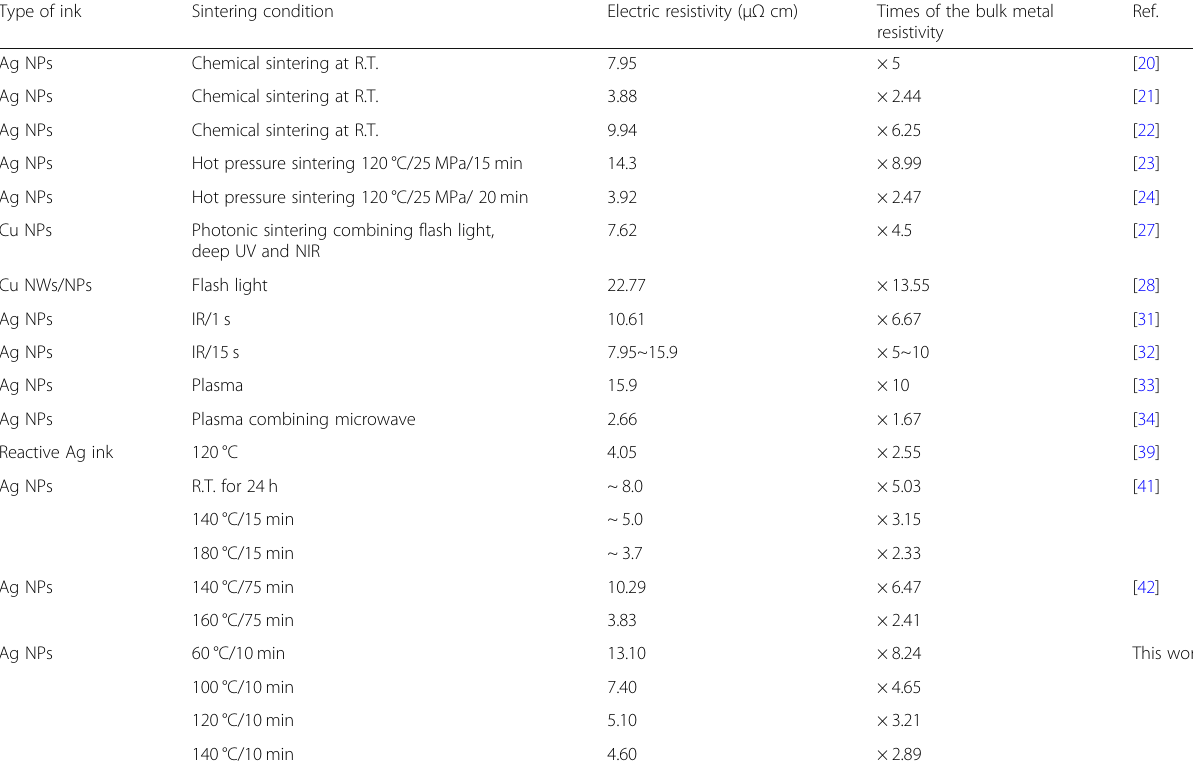
Table 3 Comparison of sintering condition and electric resistivity of this work with those of in reported literatures Type of ink Sintering condition Electric resistivity ( μΩ cm)